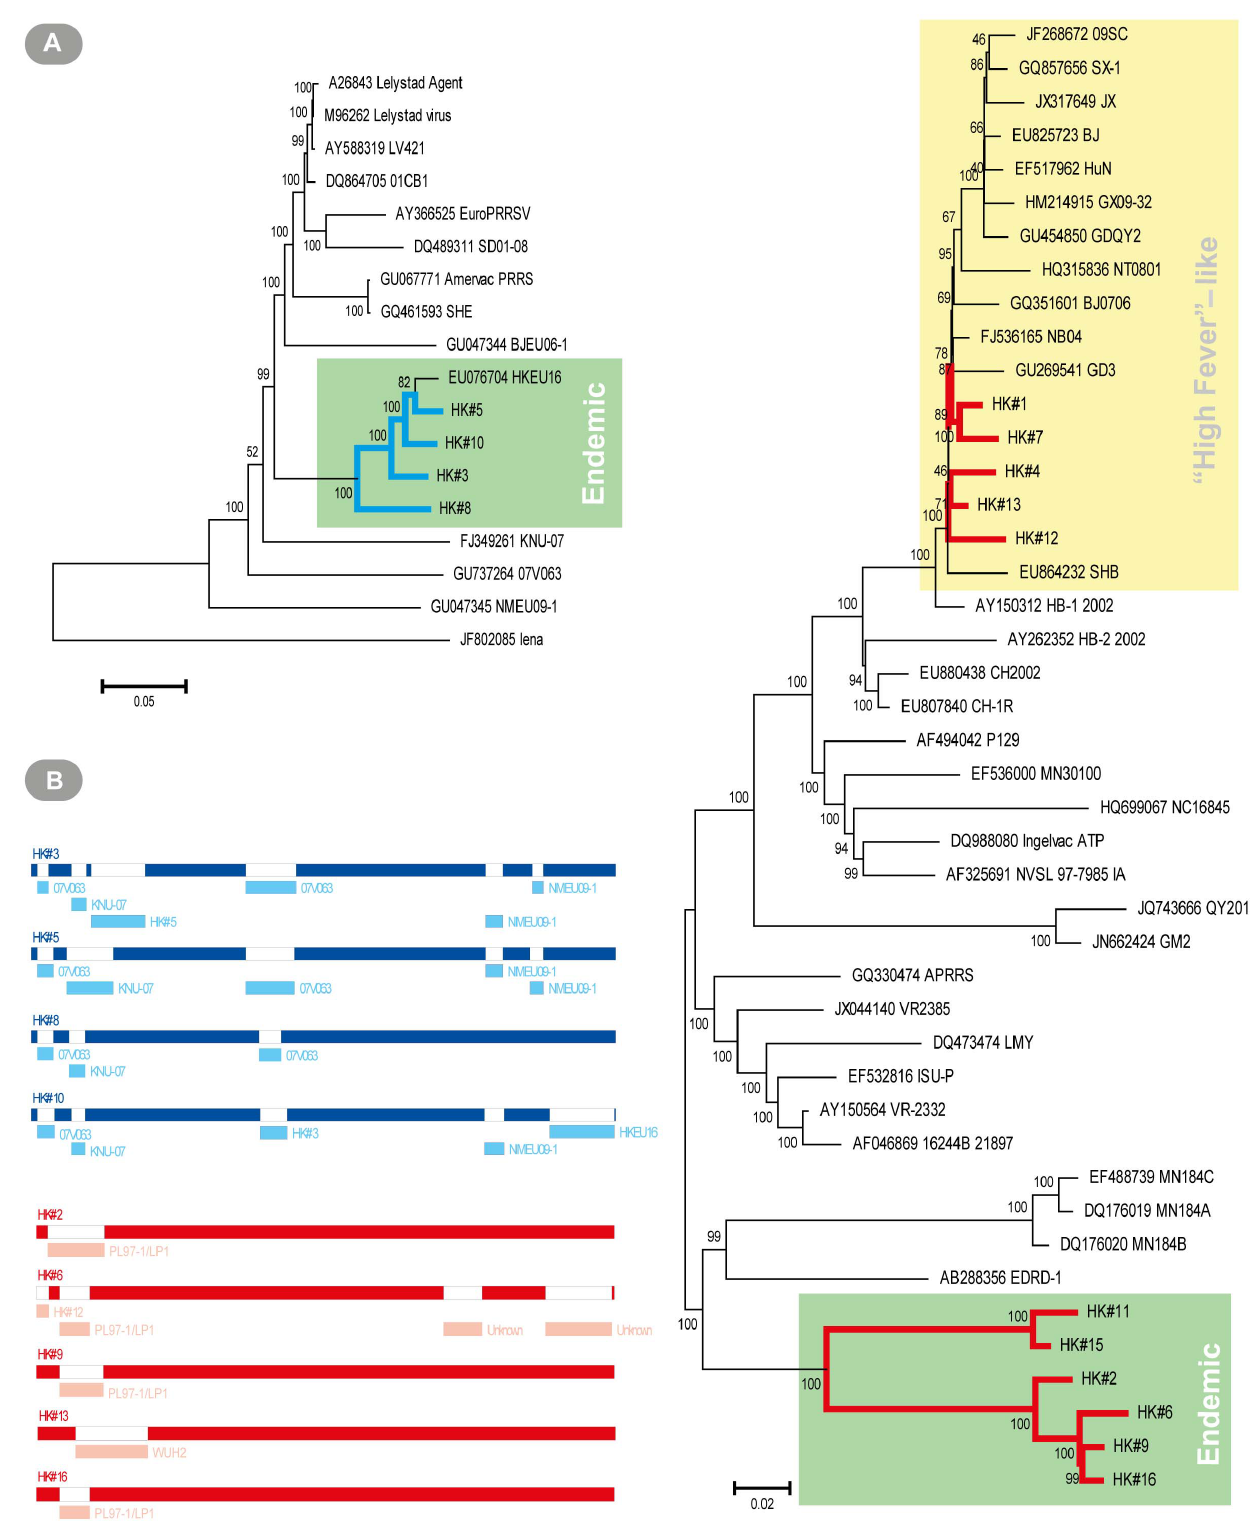
Figure 2. Phylogenomic and recombination characterization of HK PRRSV strains. (A) Genotype-specific (type 1 left; type 2 right) phylogenies of HK and globally sequenced PRRSV genomes. Type 1 strains form a monophyletic clade separate from isolates of any other country or region. Type 2 strains classified with either previously known local as known as ‘‘endemic’’ diversity or the ‘‘High-Fever’’-like variants isolated during virulent outbreaks of PRRS in China. (B) Mapped recombination breakpoints and potential minor parental-like strains of mosaic HK PRRSV strains. Unknown designation (for a missing parental-like strain) was assigned when a recombination event was characterized from an alignment involving only one parental-like strain and the recombinant. doi:10.1371/journal.pone.0088807.g002 PLOS ONE |